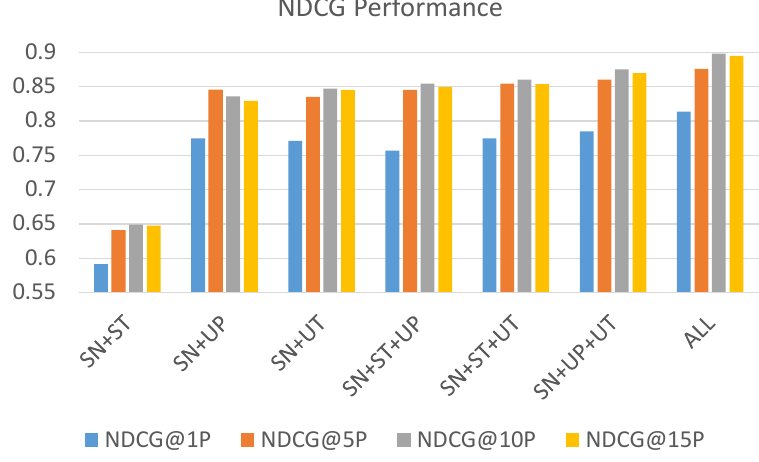
Figure 12. NDCG performance of different component